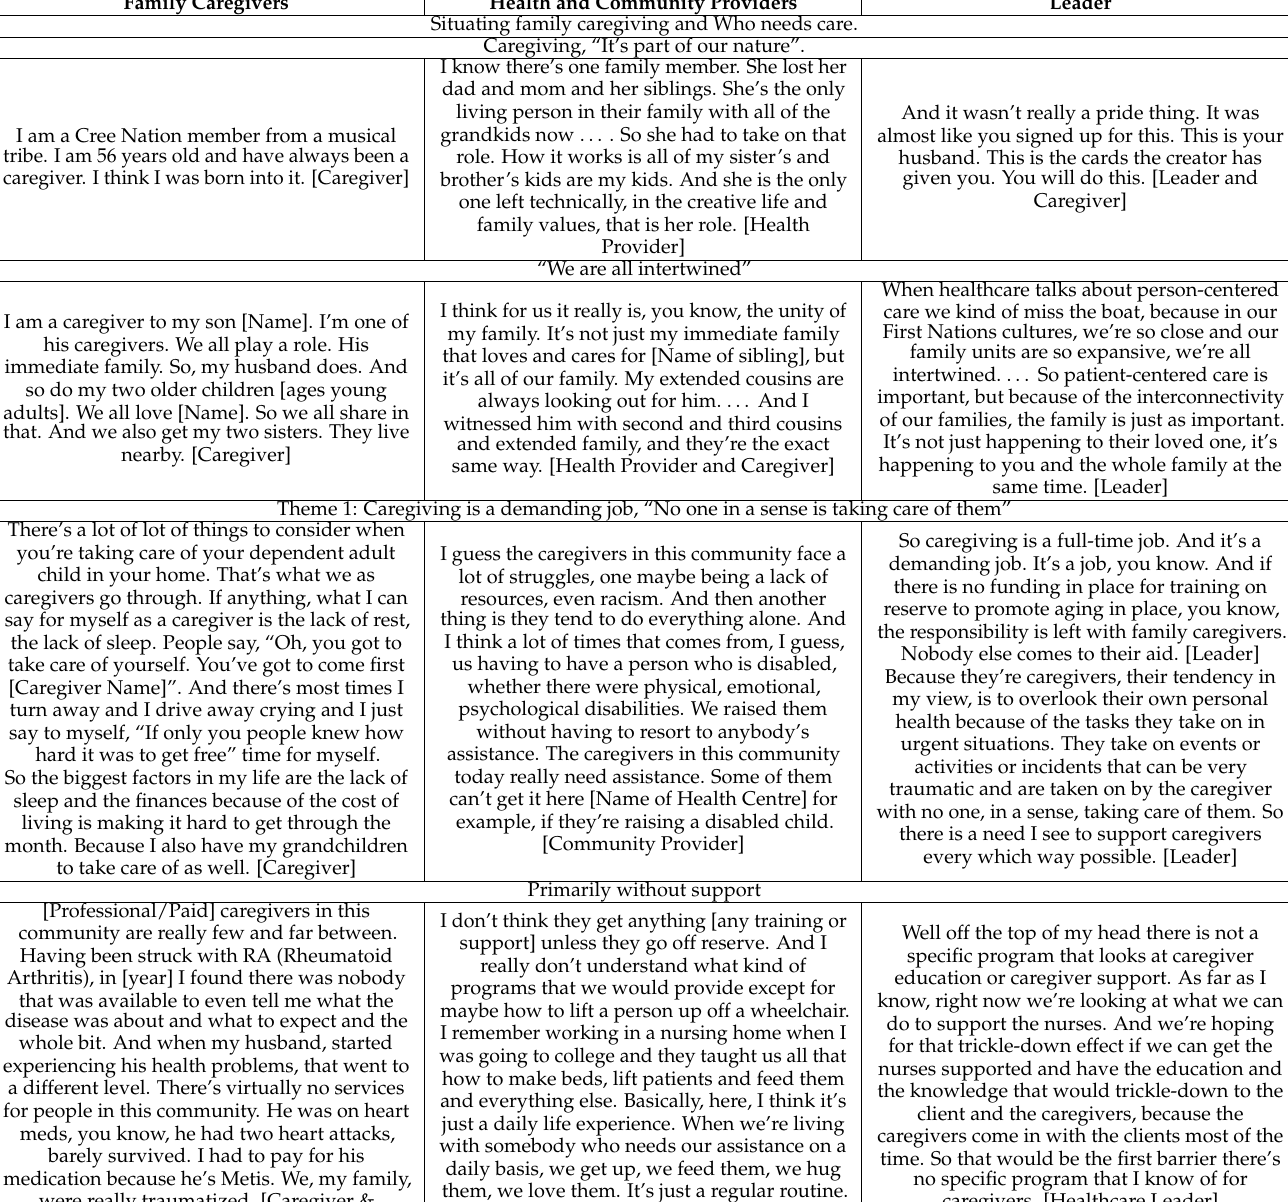
Table 2: Exemplar Quotes by Theme: Family Caregivers, Health and Social Care Providers, and Leaders